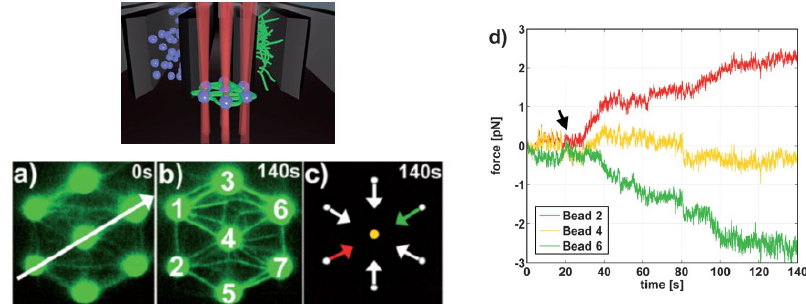
Figure 11. Actin network construction and optical force sensor array [126] . ( a ~ c ) A constructed biomimetic quasi-two-dimensional actin network. ( d ) Measuring force on beads with HOT.